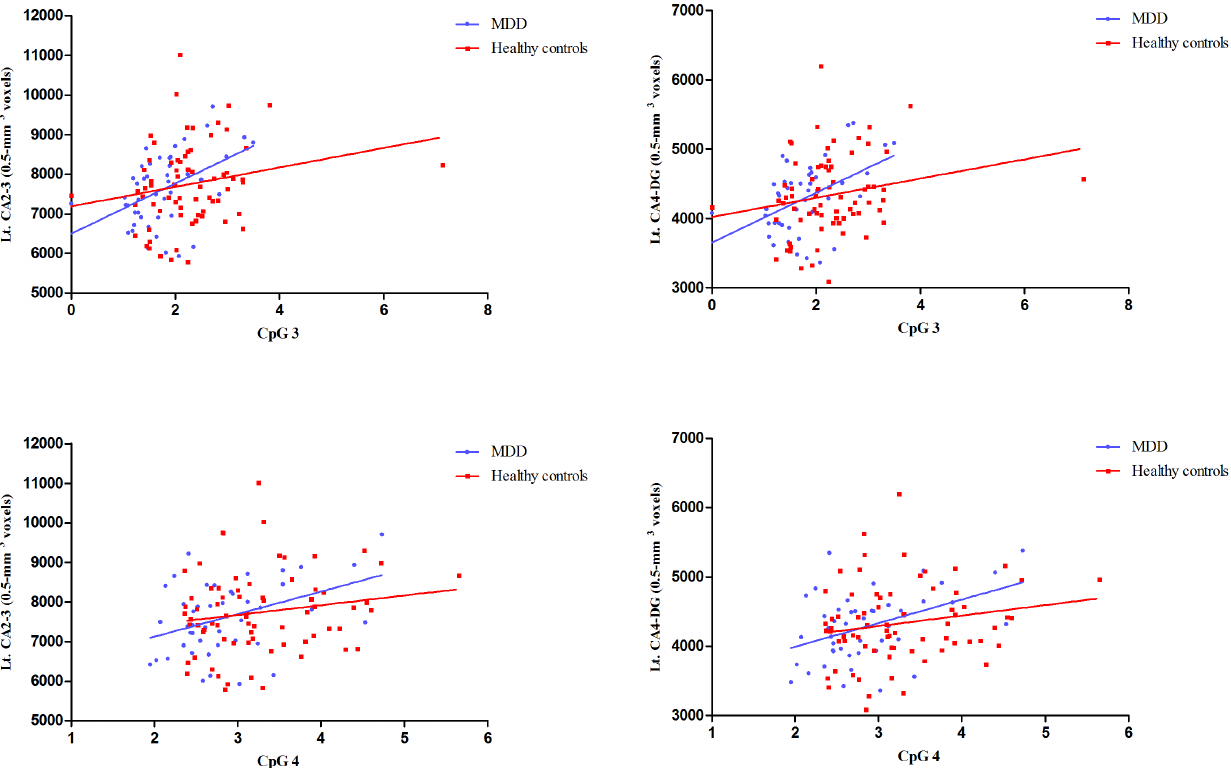
Figure 6. Correlations between NR3C1 methylation at CpG2-3 and hippocampal subfield volumes among participants.